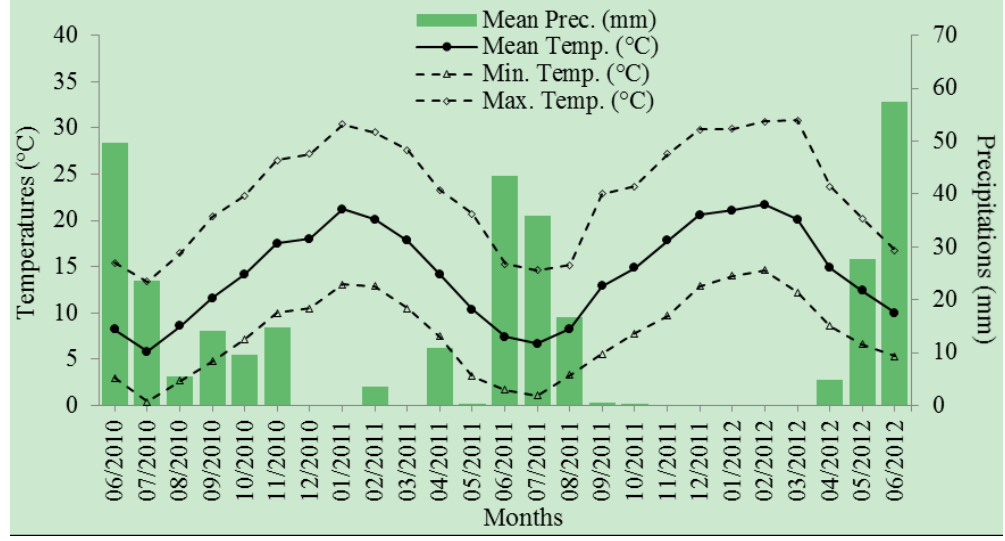
Figure 1. Monthly temperature (mean, minimum and maximum) (lines) and mean precipitation (bars) during the period of field establishment (2010–2012) (Source: Estación Pudahuel, Dirección Meteorológica de